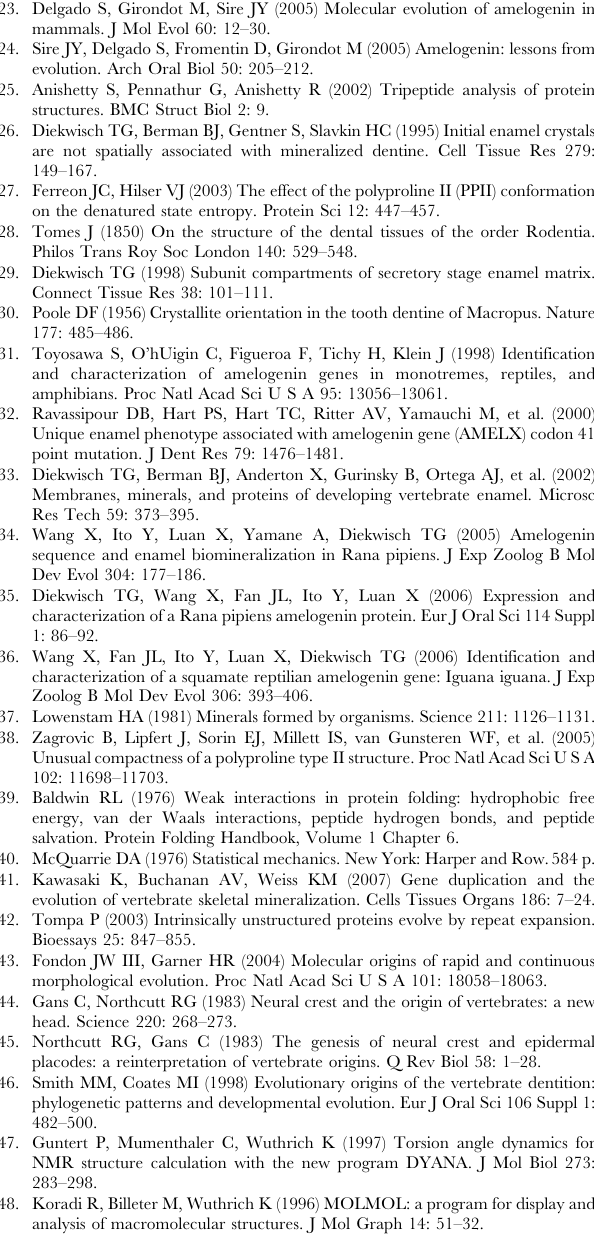
Table S1 PXX33 chemical shift table.